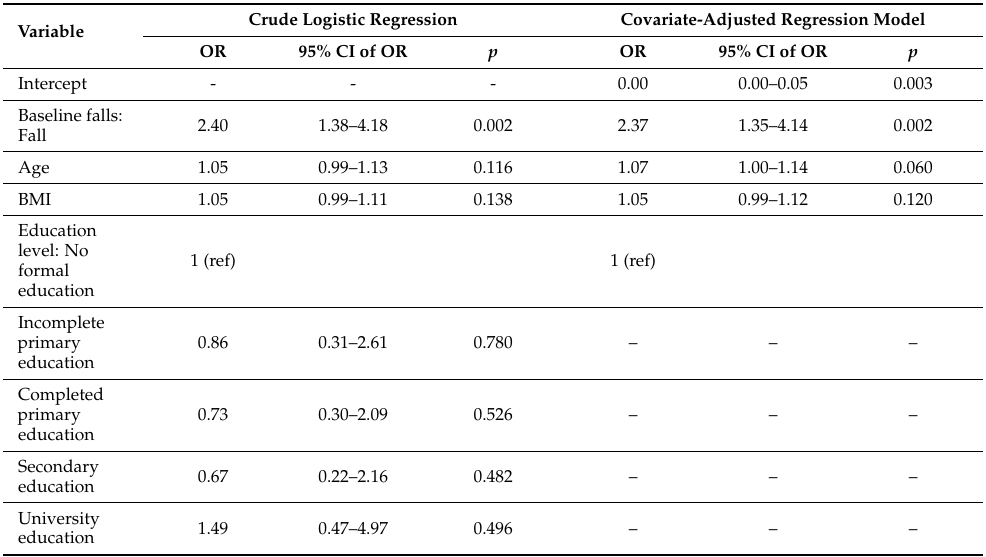
Table 3. Crude and adjusted logistic regression models of falls associated factors at 6